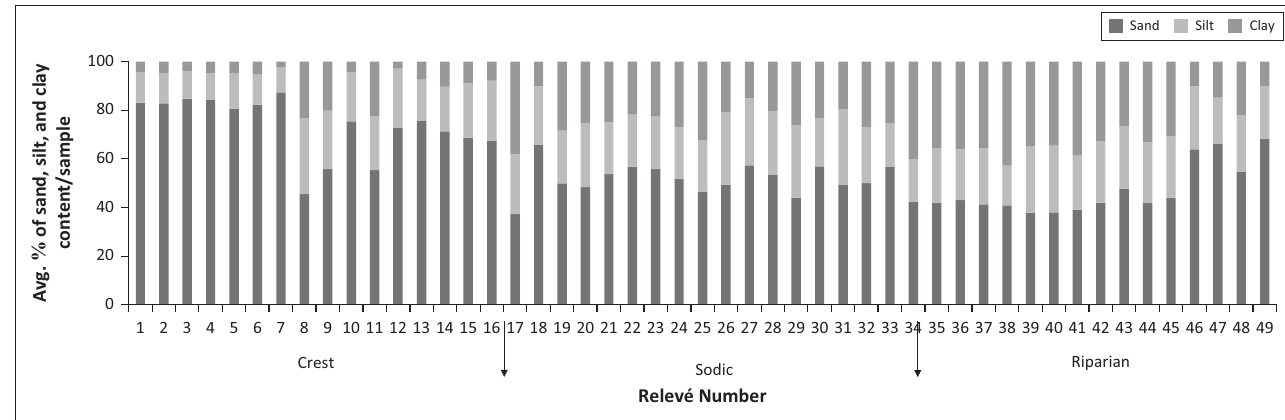
FIGURE 4: Sand, silt and clay content per soil sample collected for each relevé along the study transect.